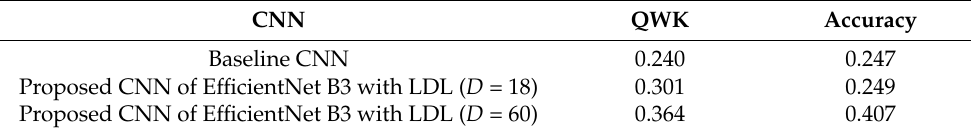
Table 5. Performance of the baseline and proposed CNNs in the unseen test set.